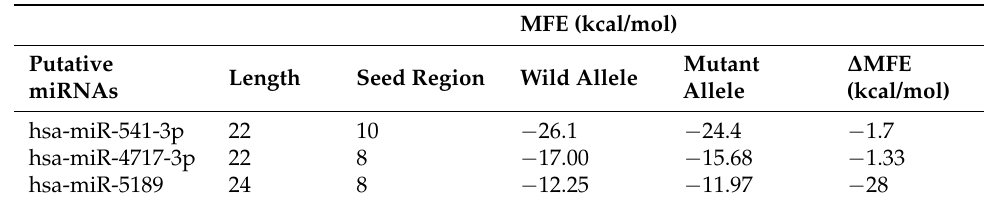
Table 7. Putative miRNA targeting PD-1.6 SNPs in the 3 ′ UTR of the PD-1 gene, and the difference in the free energy of hybridization (ΔFME) for wild -type and variant alleles.